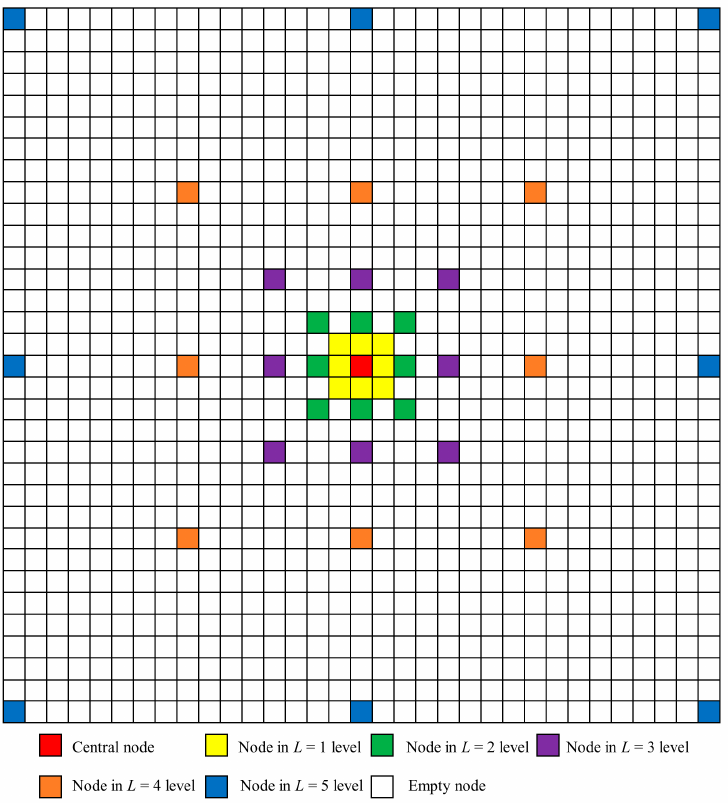
Figure 3. The data template of 3 × 3 pixels with a multi-grid level, L , of 5.